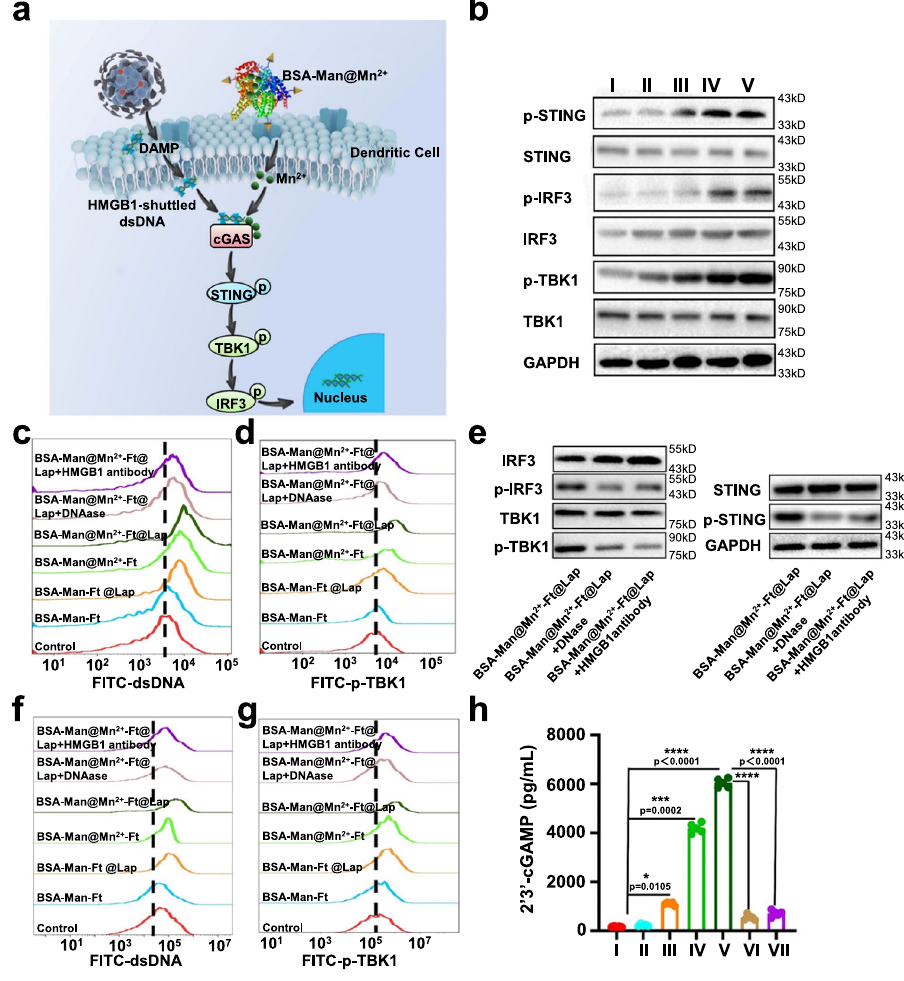
Fig. 4 | BSA-Man@Mn 2+ -Ft@Lap nanoassembly stimulates cGAS-STING- mediated dsDNA sensing machineries in DCs. a Schematical illustration of the nanoassembly-stimulatedcGAS/STINGsignalingof DCsinthe TME. b